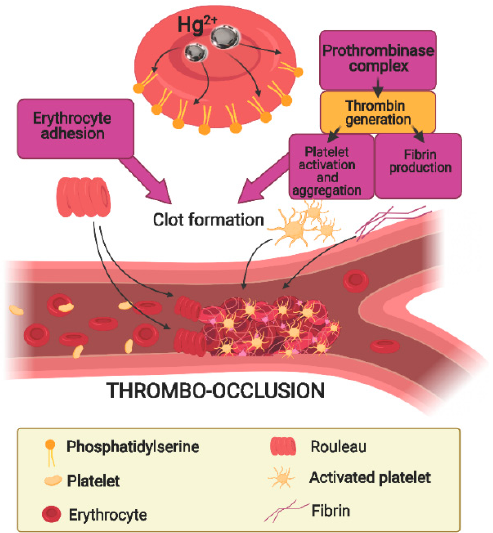
Figure 3. Hg-induced procoagulant activity in RBC. Hg-induced PS exposure on the outer surface of RBC enhances RBC adhesion to the endothelial cells. Moreover, PS-bearing RBC and MVs provide a site for assembling the prothrombinase complex, leading to thrombin generation and clot formation.